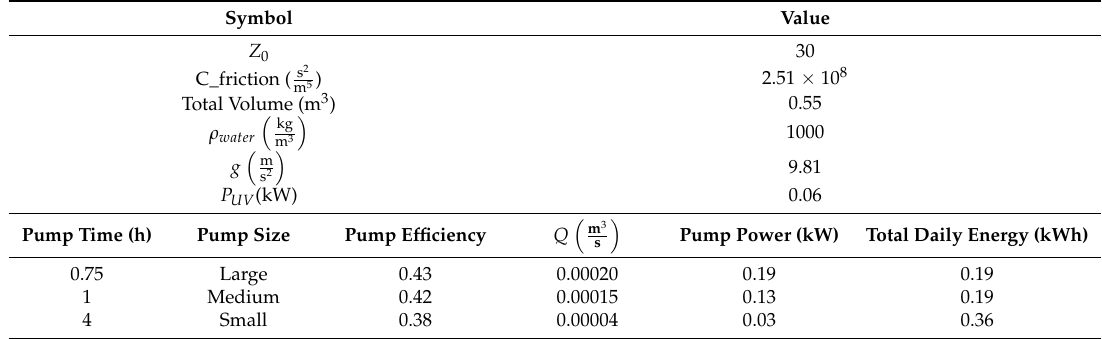
Table 9. Energy Calculations for the PS-TO